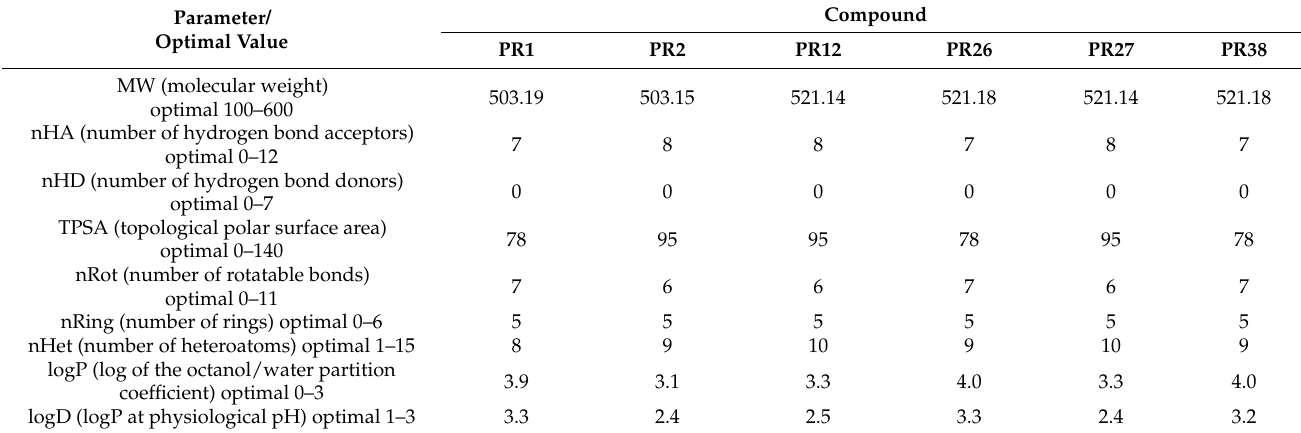
Table 2. Physicochemical properties of studied compounds.